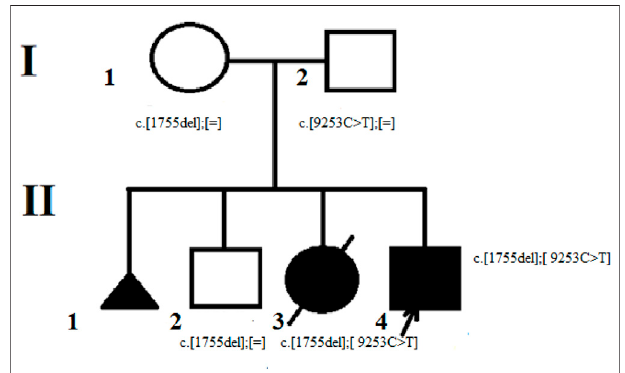
FIGURE 1 | The proband ’ s family pedigree. The mother of the proband (I-1) is the carrier of the c. 1755del variant. The father of the proband (I – 2) is the carrier of c. 9253C > T variant in mosaic form. The brother of the proband (II-2) is also the carrier of c. 1755del variant. The proband (II-4) and his deceased sister (II-3) were found to have two pathogenic variants s . 1755del and c. 9253C > T.